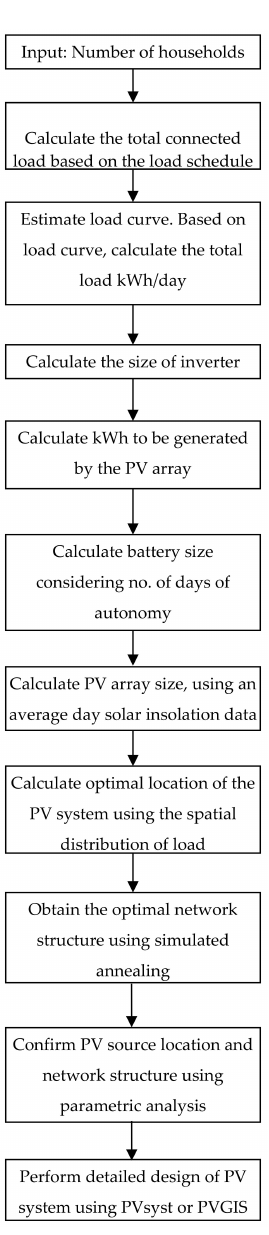
Figure 16. Proposed method for planning of isolated PV microgrids for rural